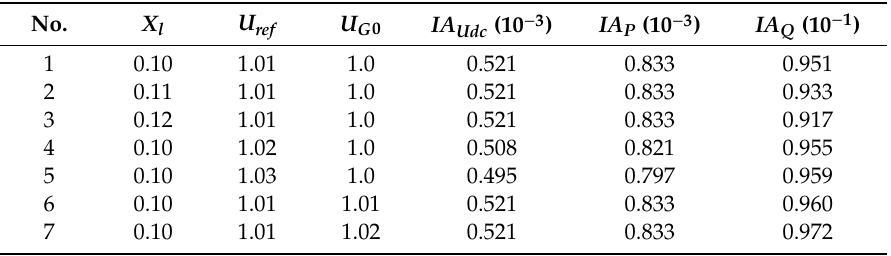
Table 6. IA of GVSC response with various